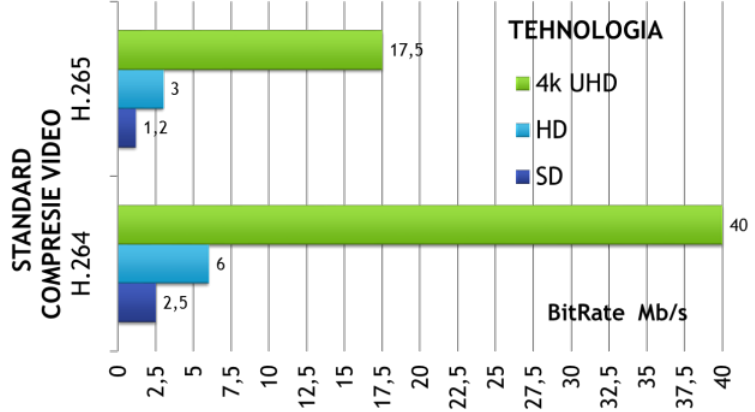
Figure 4. Compression capabilities of H.264 and H.265